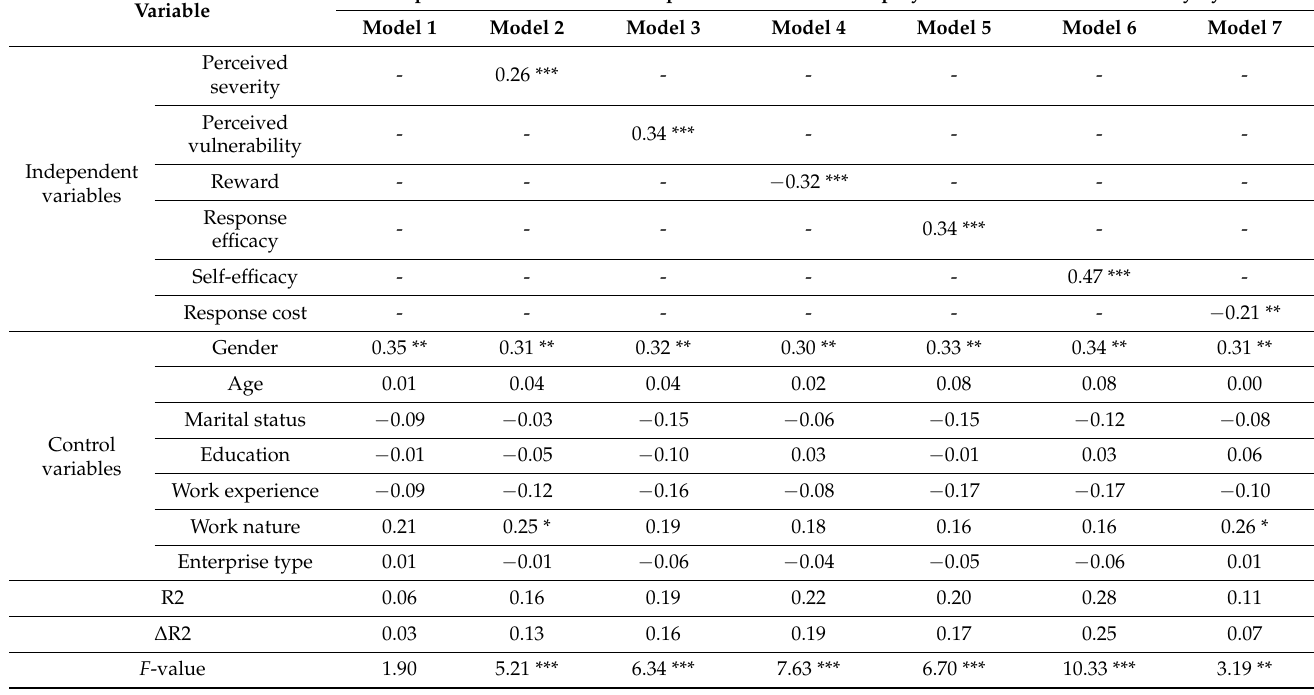
Table 5. Results of the regression